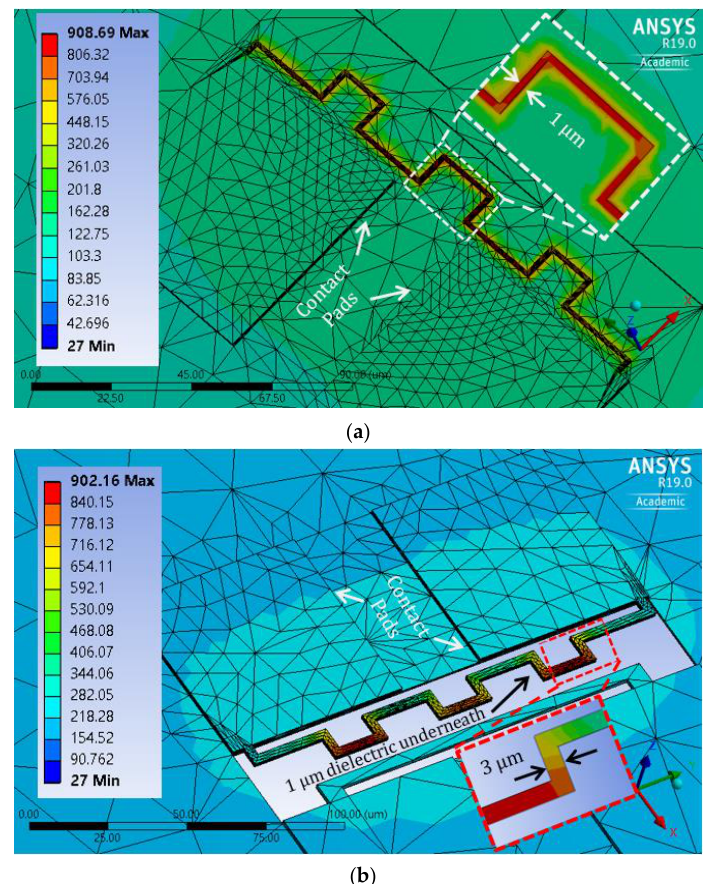
Figure 7. Thermal–electric simulation results of Ni 3 Al designs: ( a ) non-suspended and ( b ) partially suspended.